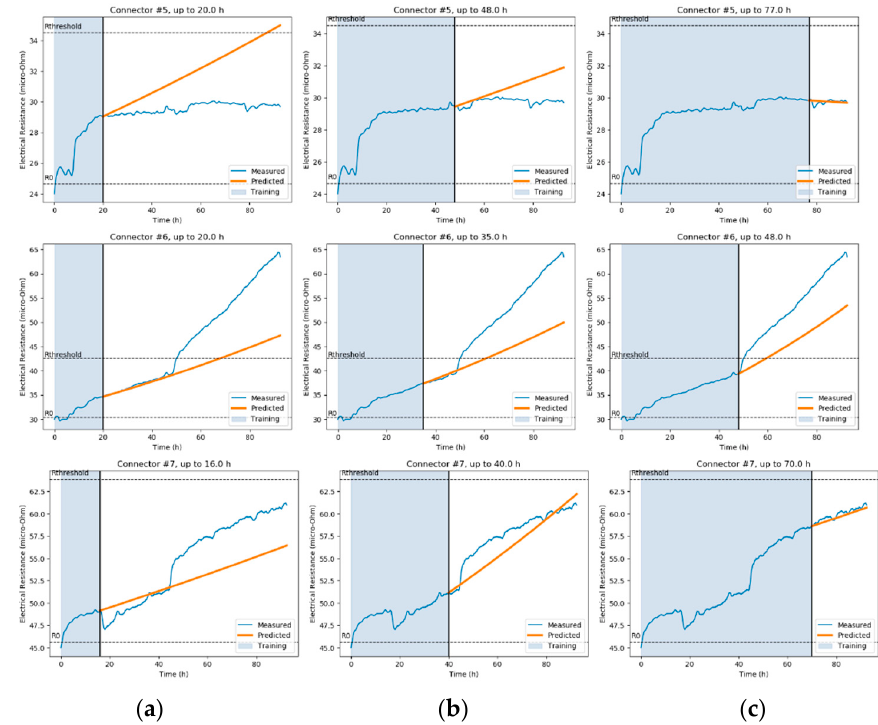
Figure 6. Autoregressive integrated moving average (ARMA) ( p = 2, q = 2) RUL prediction of the analyzed connectors (#1 to #7) for time instants ( a ) 1, ( b ) 2, and ( c )